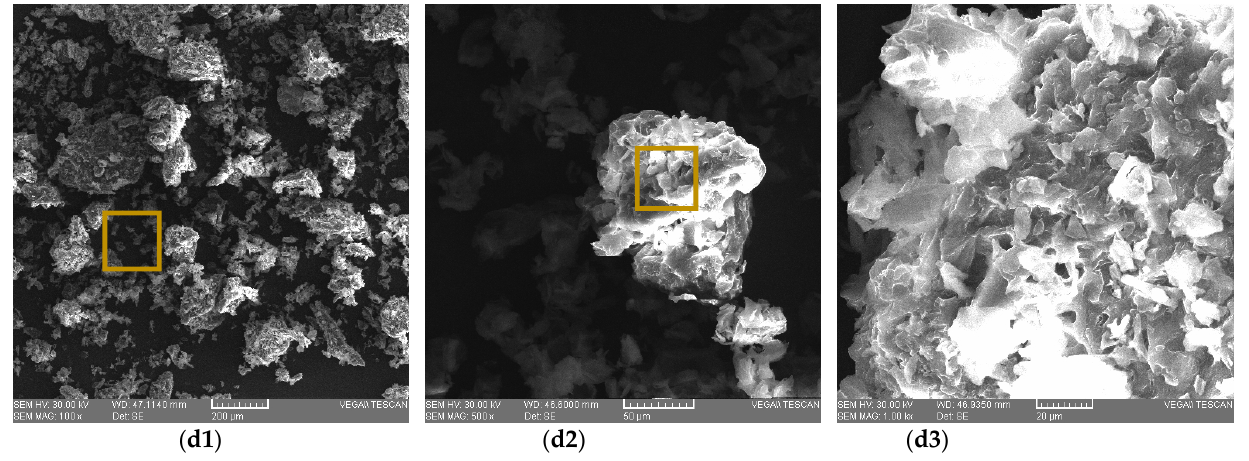
Figure 1. SEM micrographs of carrot pomace powders of Baltimore ( a ), Belgrado ( b ), Niagara ( c ), and Sirkana ( d ) varieties at 100× (1), 500× (2), and 1000× (3) magnification. The regions enlarged are marked with a yellow border.